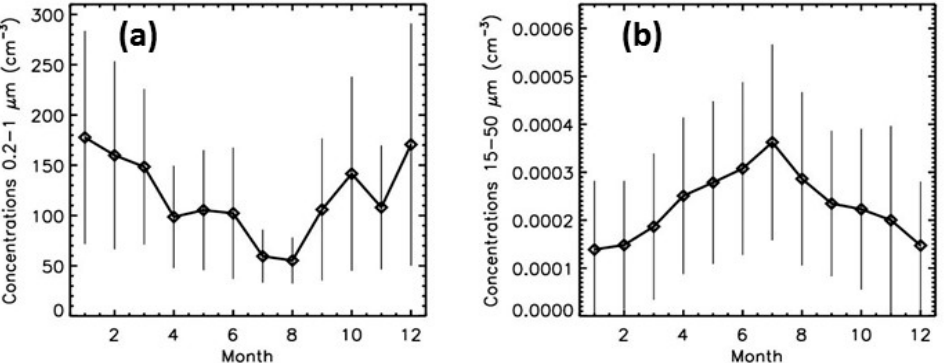
Figure 6. Annual evolution of the concentrations for the smallest particles (a) and the biggest particles (b) detected by LOAC for the six-year period; the vertical bars correspond to the mean absolute deviation of the concentrations.